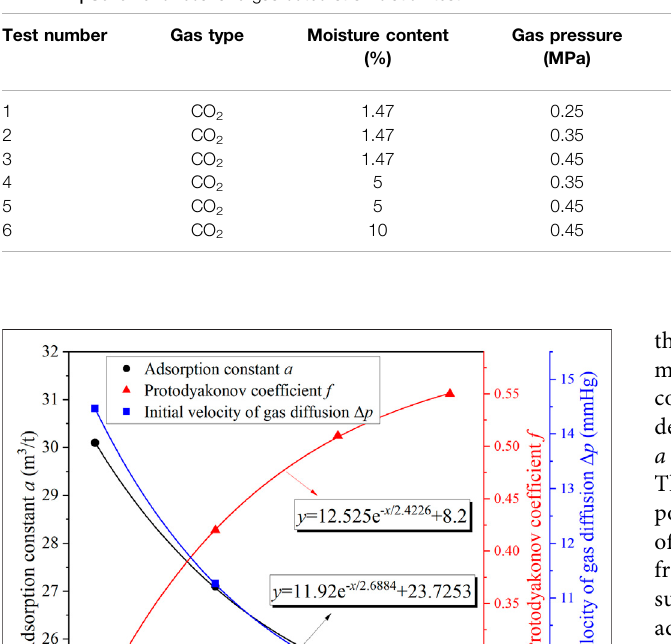
TABLE 1 | Scheme for coal and gas outburst simulation test.